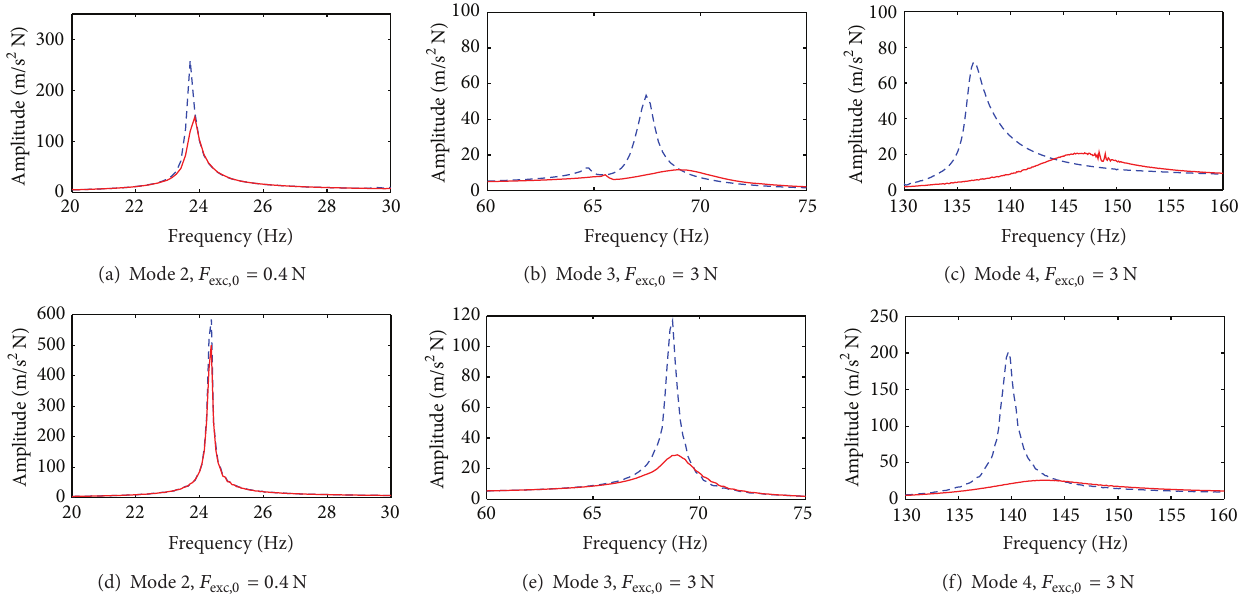
Figure 8: Lyapunov-type control: measured (top) and simulated (bottom) accelerance FRFs for controlled sine-sweep excitation with (solid) and without (dashed) control ( 𝜀 = 1/200 m /